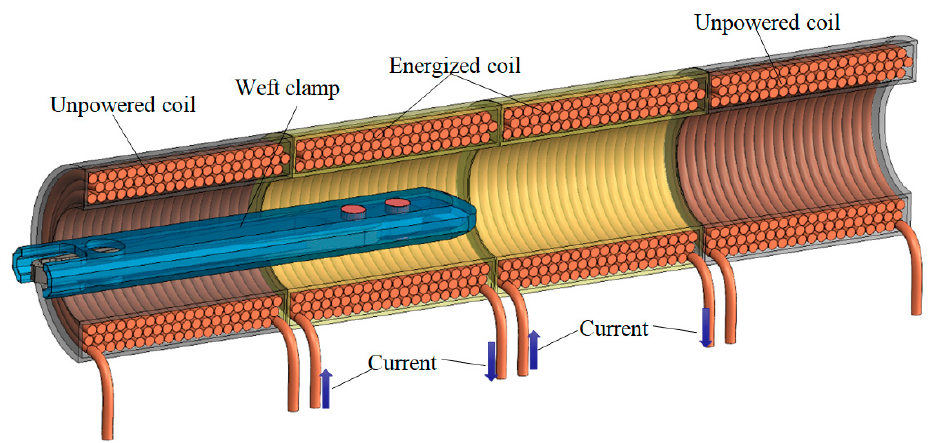
Figure 5. Schematic diagram of a multi-stage segmented combined coil.